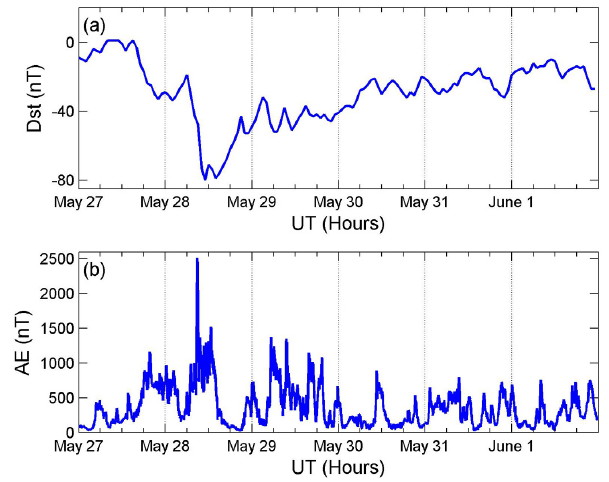
Fig. 2. Temporal variations in the Dst index (a) and AE indices (b) during 27 May–1 June